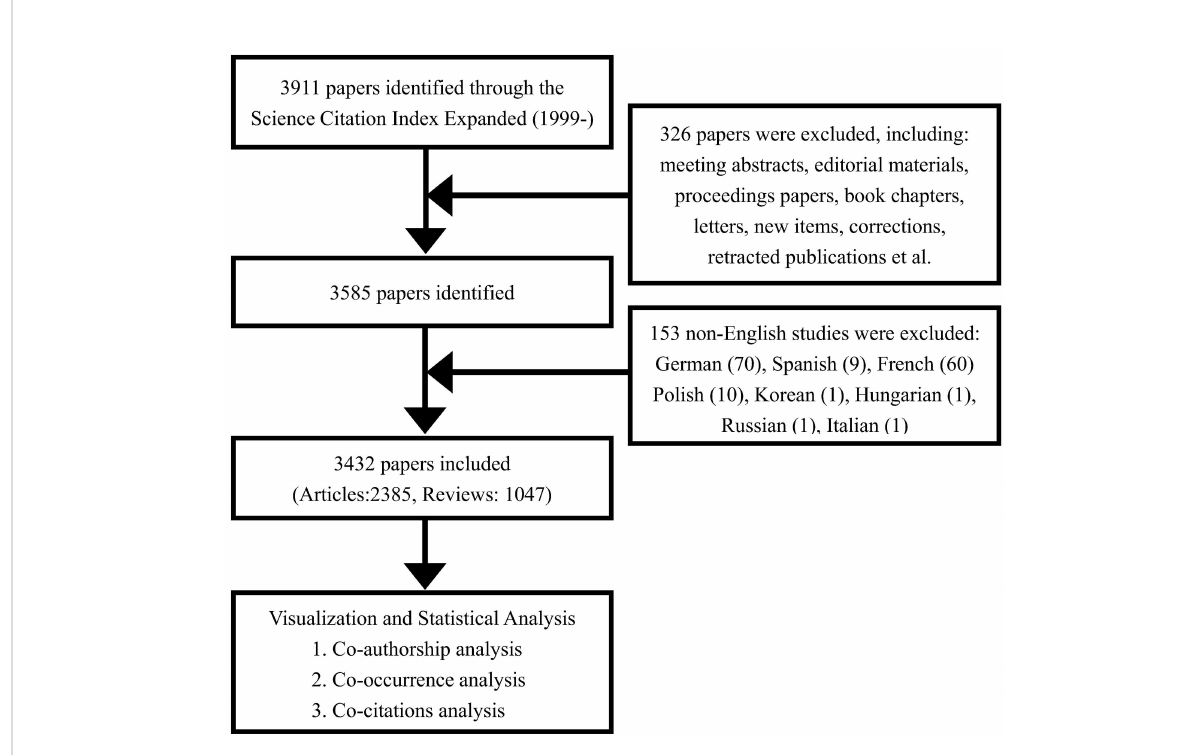
FIGURE 1 Flowchart of the literature searching and screening in the